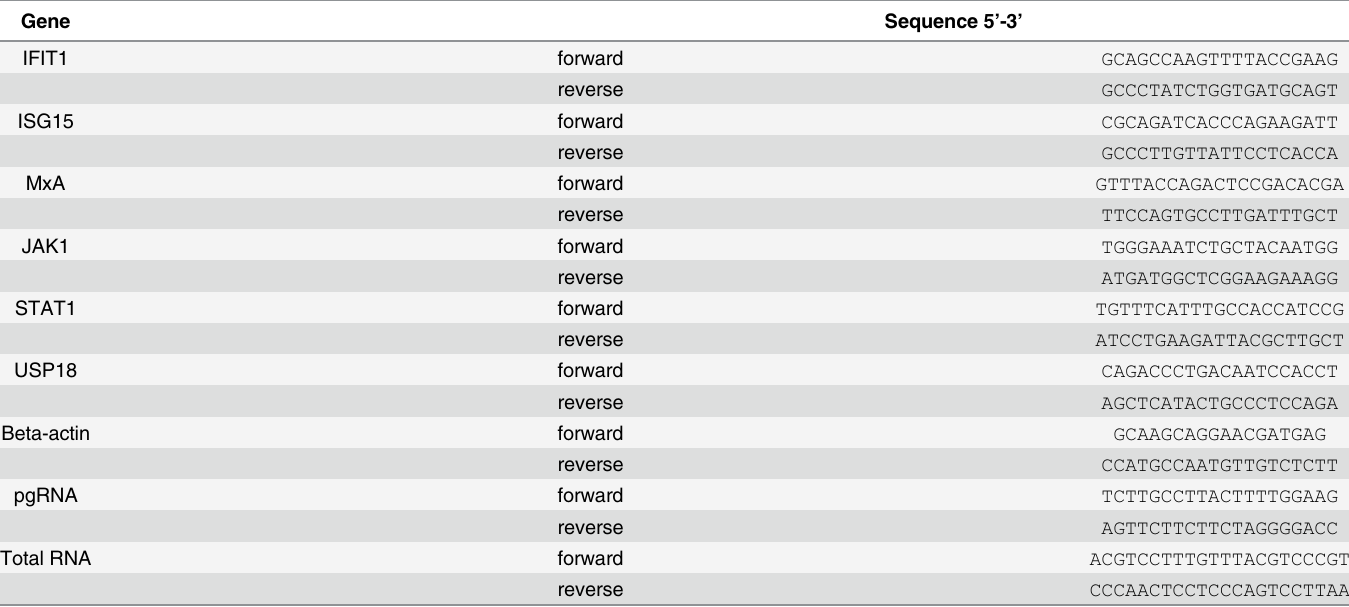
Table 1. Primers for quantitative real-time